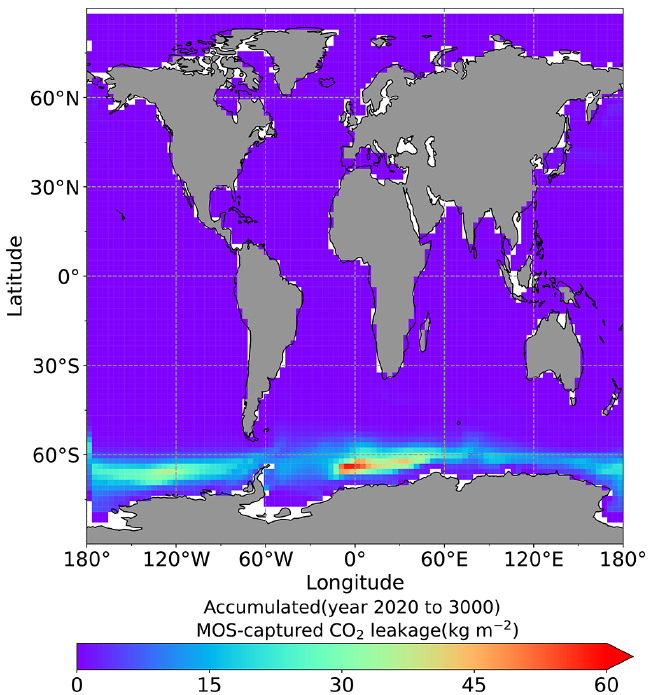
Figure B5. Cumulative (year 2020 to 3000) leakage of MOS-captured carbon in the simulation MOS_Stop.